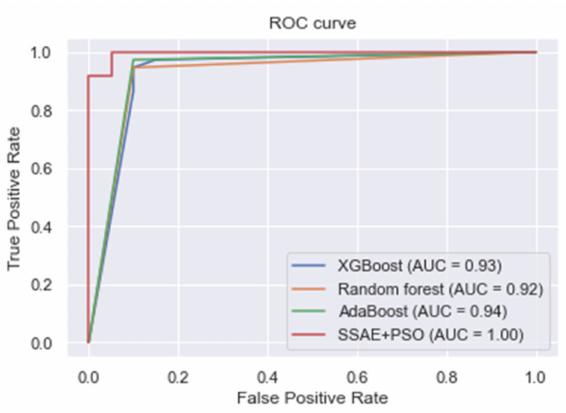
Figure 4. ROC curve of the classifiers using the cervical cancer dataset.